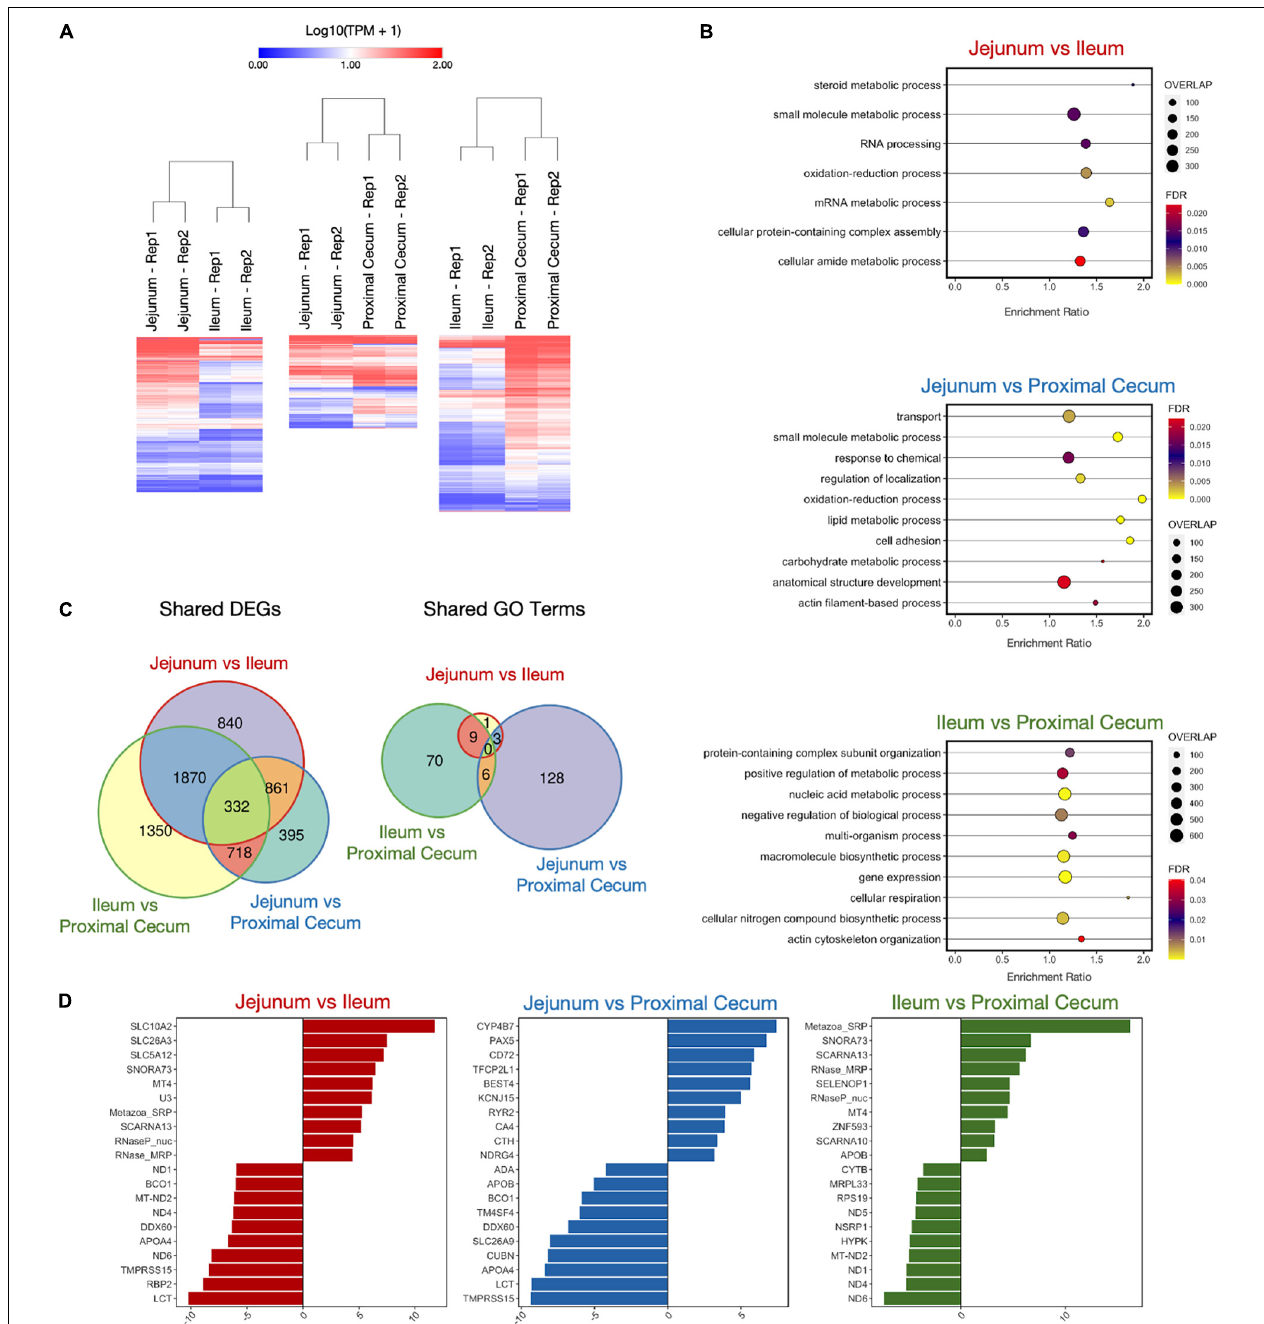
FIGURE 6 | Differentially Expressed Gene (DEG) Analysis on Intestinal Samples. (A) Heatmaps of DEGs in three cell type comparisons: Jejunum vs. Ileum (3903 DEGs), Jejunum vs. Proximal Cecum (2306 DEGs), Ileum vs. Proximal Cecum (4270 DEGs). Samples were clustered both by column and by row using Euclidean distance based on log transformed TPM value. (B) Enriched GO Biological Process categories for each sample using weighted set cover filtering in WebGestalt. “Overlap” quantities the number of DEGs present in that GO set. (C) The numbers of DEGs overlapping between sample comparisons. (D) Log 2 fold-change of top 10 upregulated and downregulated DEGs for each sample